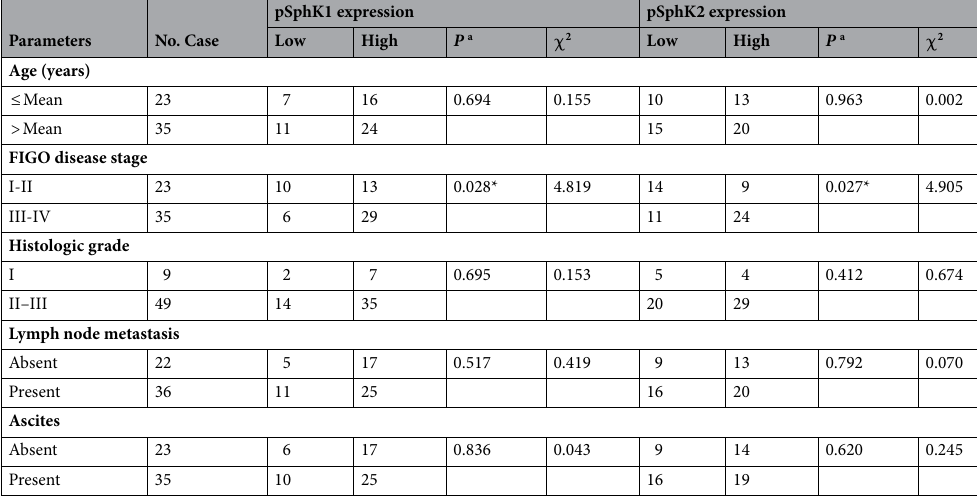
Table 1. Clinicopathological features of ovarian tissue with regard to the relative expression of pSphK1 and pSphK2. P values are calculated by χ 2 test or Fisher’s exact